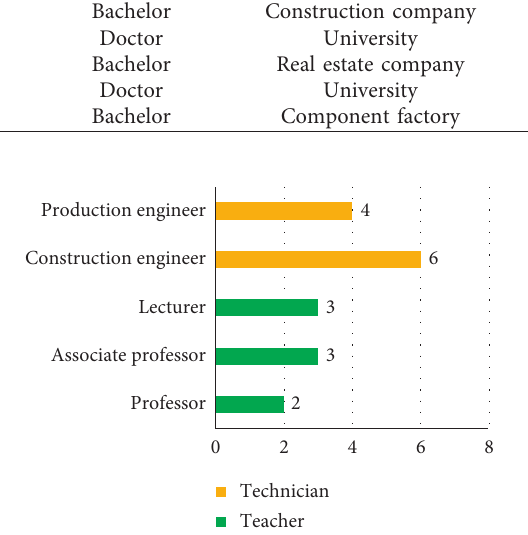
Figure 3: Basic information for brainstorming